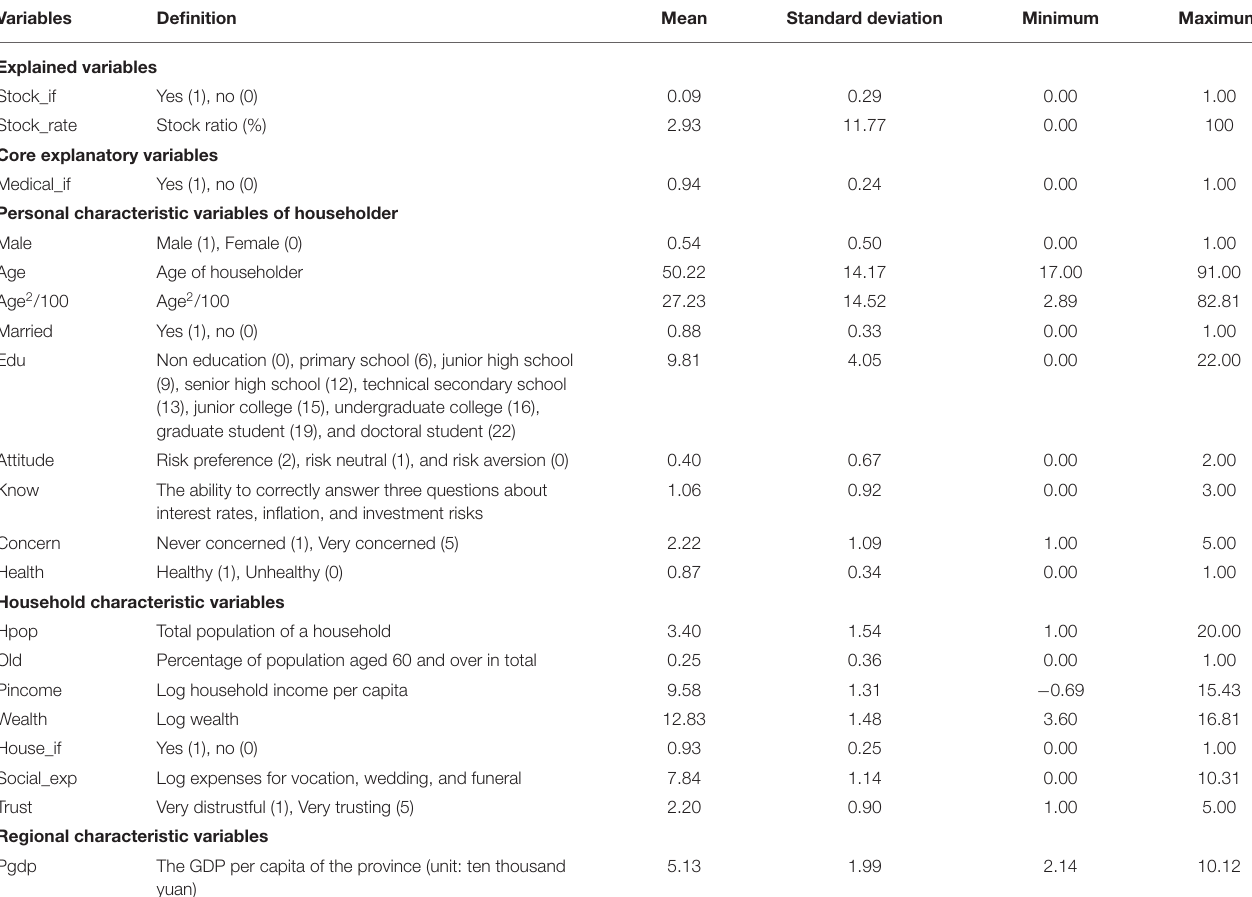
TABLE 3 | Variable description and descriptive